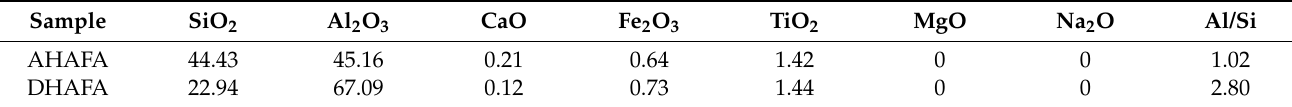
Table 2. Chemical compositions of AHAFA and DHAFA (wt.%).